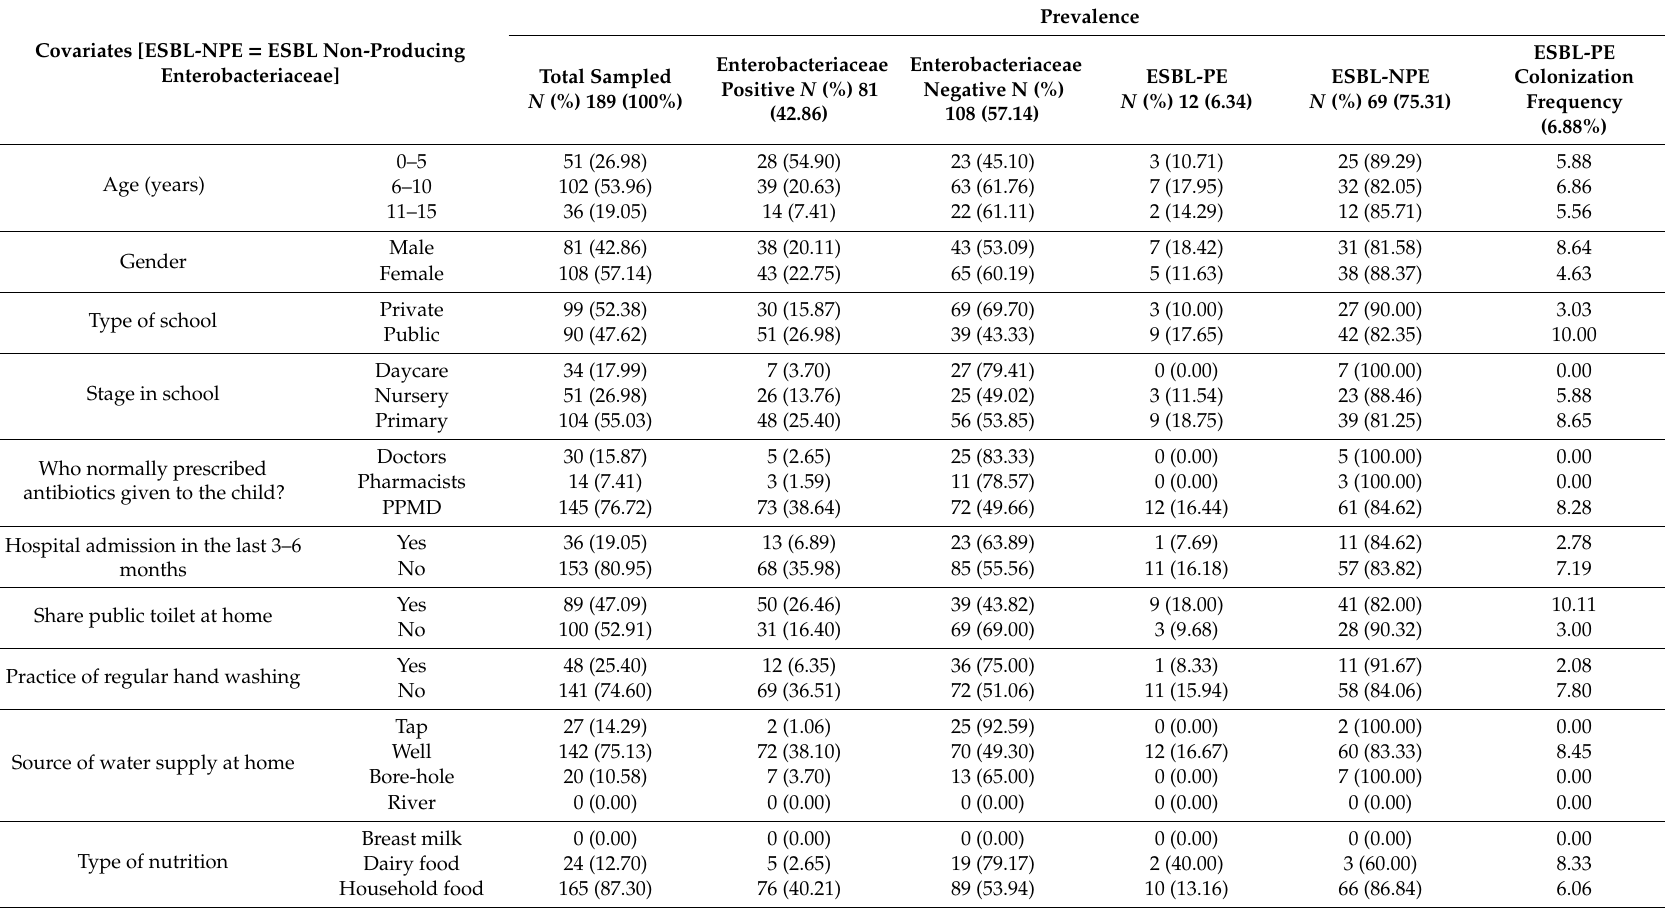
Table 4. Survey of risk factors associated with ESBL-PE carriage among the apparently healthy